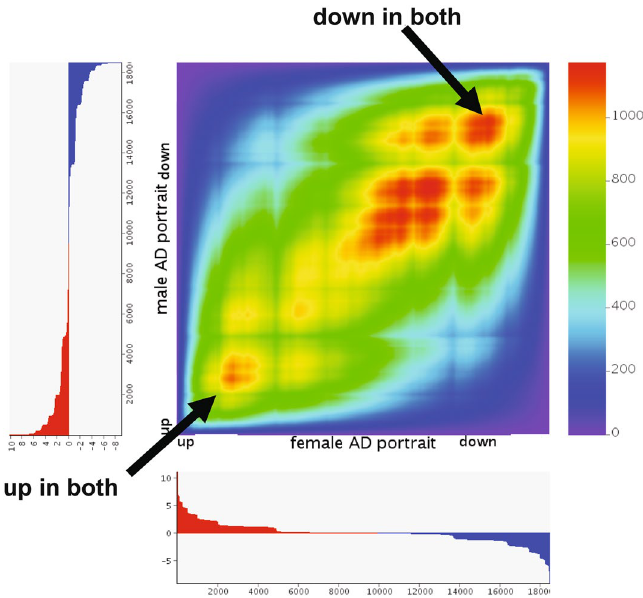
Figure 2. High congruence of male and female AD portraits. RRHO heat map 111 is shown for comparisons of the male AD portrait (Y axis) and the female AD portait (X axis). Color is − log transformed hypergeometric p value showing the strength of the overlap as positive or negative enrichment. There is a high level of similarity in downregulated genes in both male and female AD datasets (red in upper right quadrant; see arrow) and in upregulated genes in both datasets (red in lower left hand quadrant; see arrow). All genes are used in RRHO analysis and upregulated genes are shown in red and downregulated genes shown in blue in the axis for each